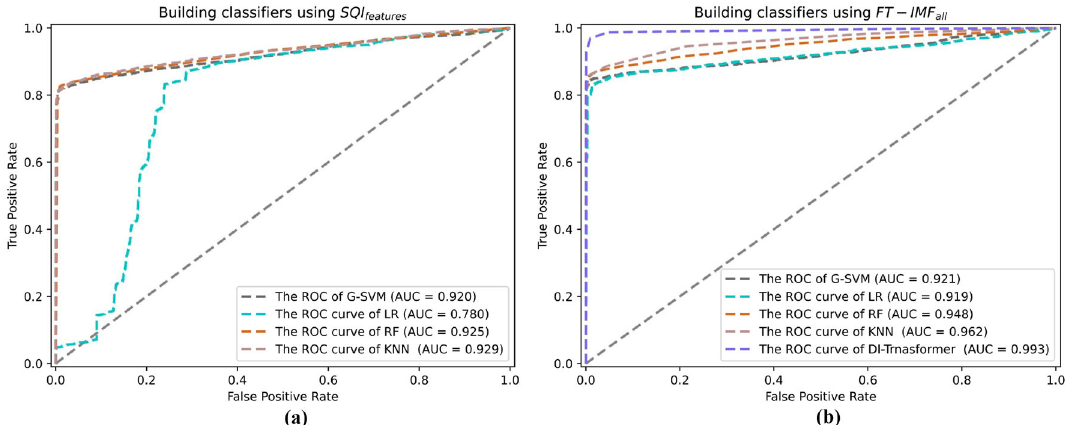
Fig. 13 ROC curves of several classification models on set-a. a ROC curves obtained on four traditional classifiers based on the SQI features feature. b ROC curves obtained on five classifiers based on the FT-IMF all